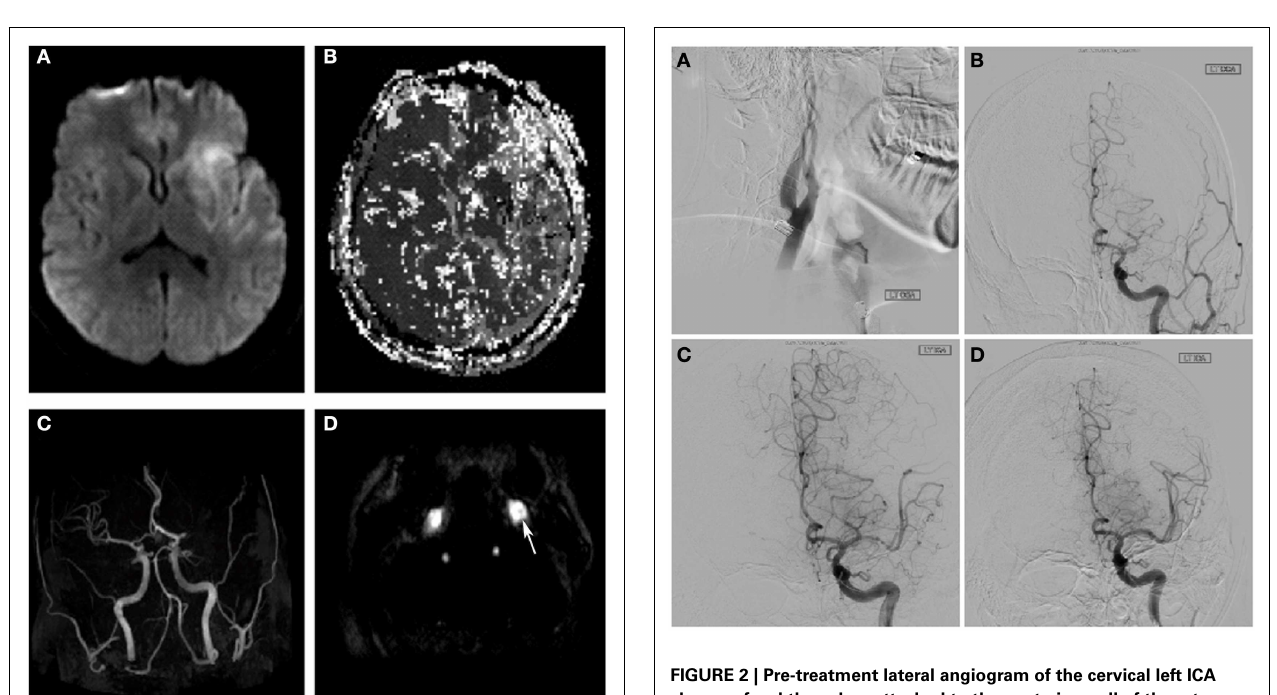
(TICI = 2a)( Figure2D ),7 hafterlastknownwelltime.Earlypost-